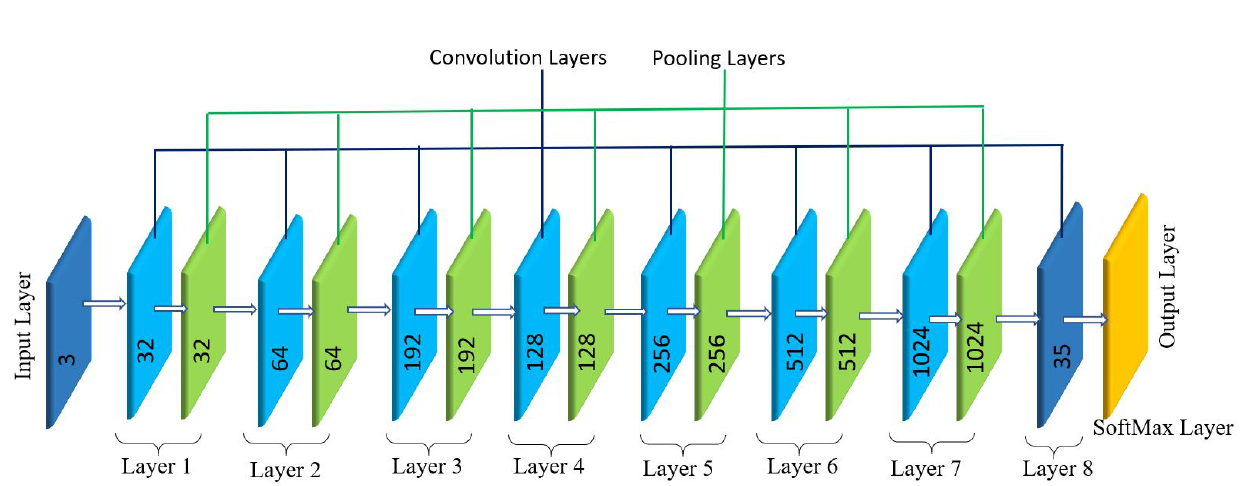
Figure 7. CNN architecture and layers